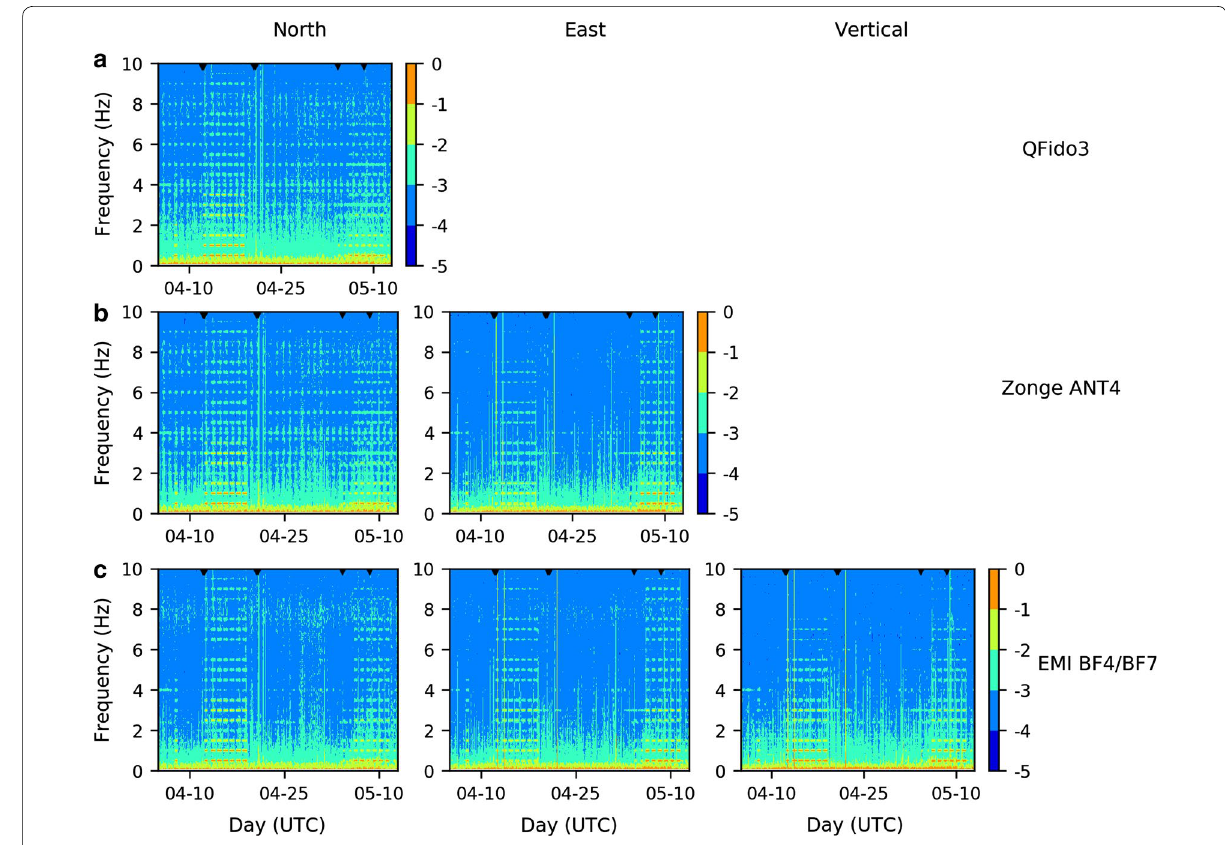
Fig. 7 Spectrograms for the time interval April 5, 2014 to May 12, 2014. a QFido3 north coil; b Zonge ANT4 north and east coils; c EMI BF4 north, east, and EMI BF7 vertical coils. The black triangles along the upper plot border show times of high geomagnetic activity (Ap >